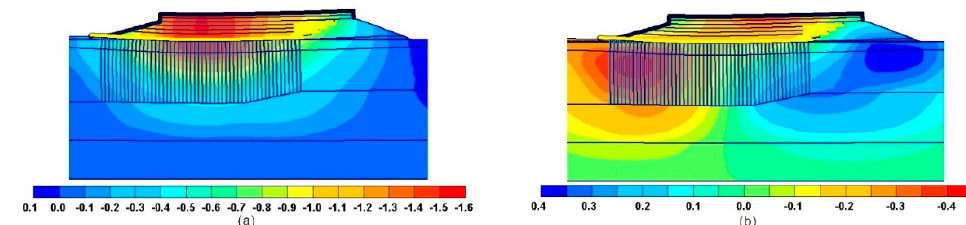
Figure 10. Vertical and horizontal displacement of the drainage line model after preloading by 1 year (m): ( a ) vertical displacement; ( b ) horizontal displacement.